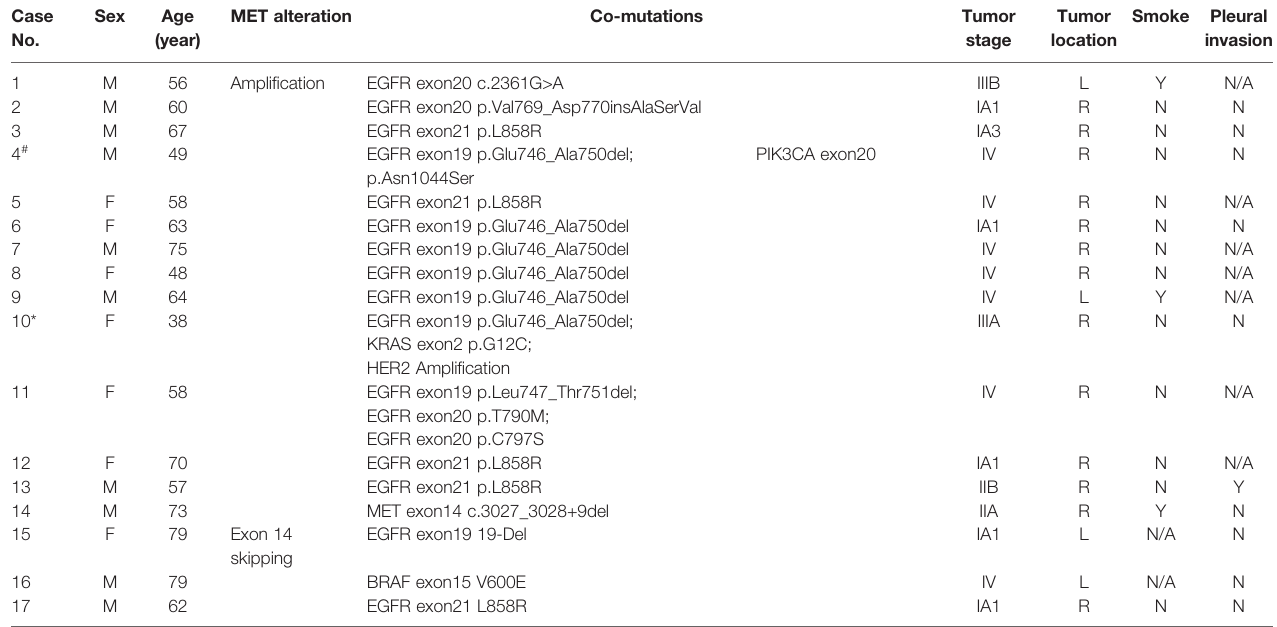
TABLE 4 | Co-mutations and clinical information of patients with MET genomic alterations. Case No.